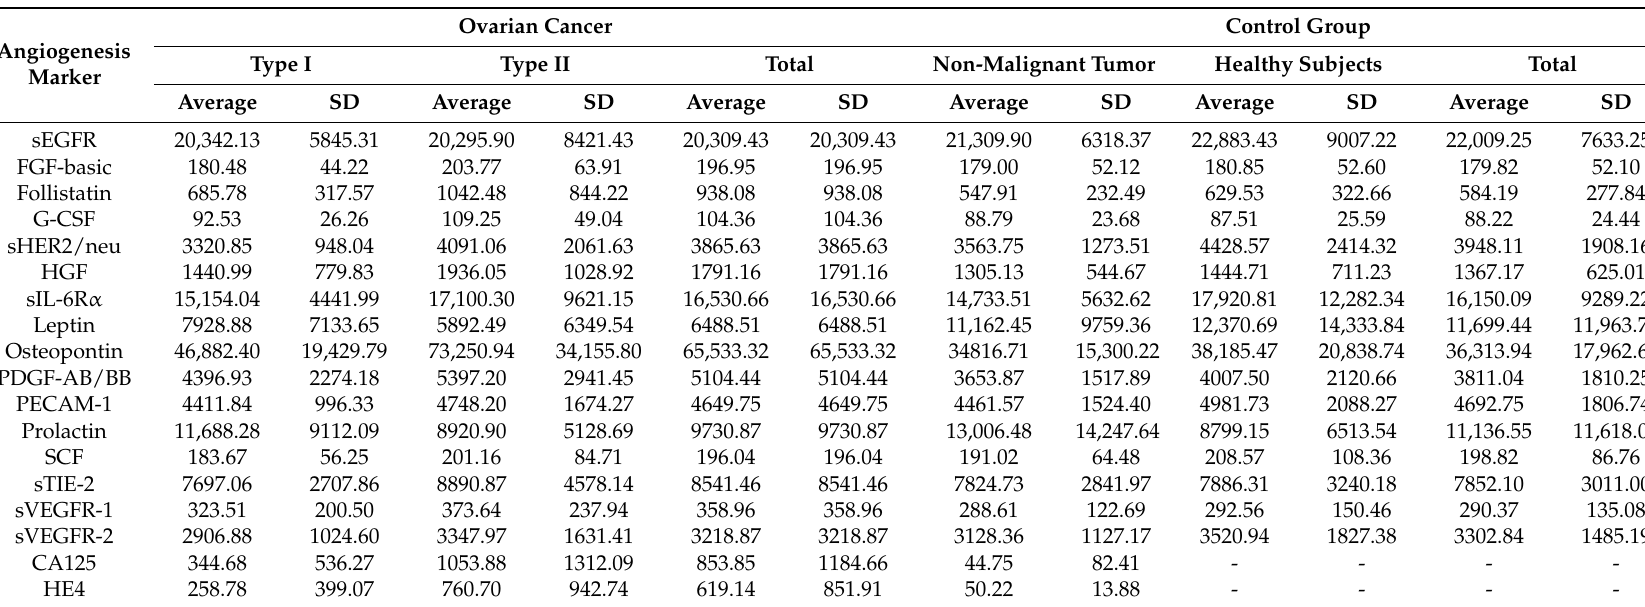
Table 1. Serum average levels and standard deviation (SD) of 16 markers: sEGFR, FGF-basic, follistatin, G-CSF, HGF, sHER2/neu, sIL-6R α , leptin, osteopontin, PECAM-1, PDGF-AB/BB, prolactin, SCF, sTIE-2, sVEGFR-1 and sVEGFR-2 in tested